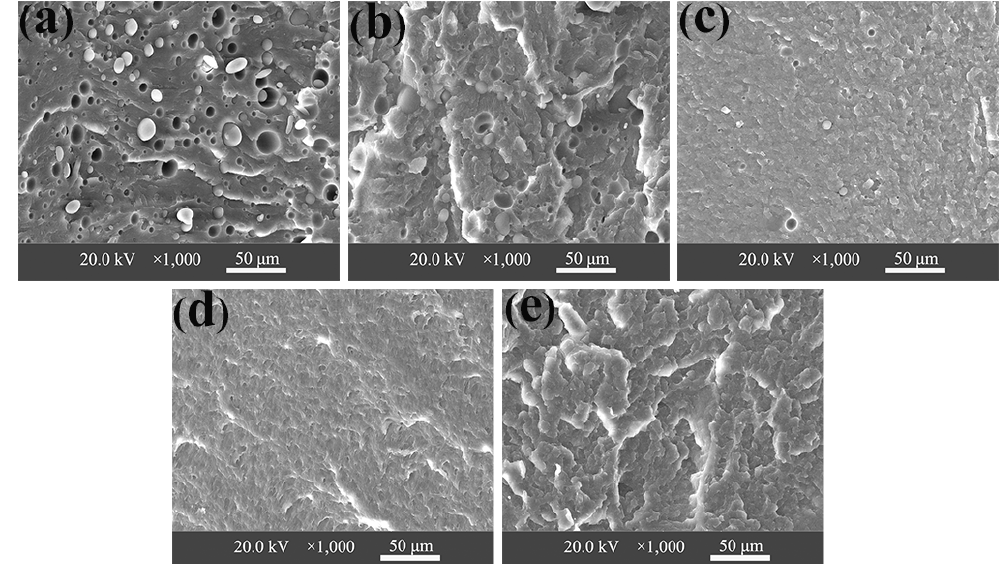
Figure 5. Scanning electron microscopy (SEM) images of the cryo-fractured surfaces of ( a ) PA6/OBC, ( b ) PA6/OBC/1, ( c ) PA6/OBC/3, ( d ) PA6/OBC/5 and ( e ) PA6/OBC/7.